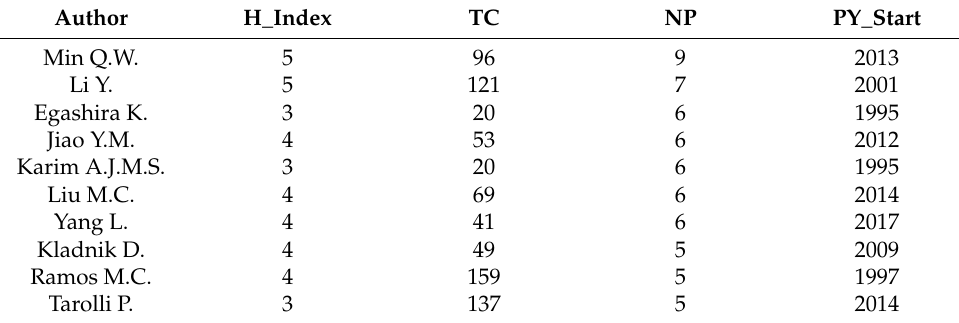
Figure 3. Authors’ publications on agricultural terraced fields over time. Table 1. Top 10 authors in the field of agricultural-terrace